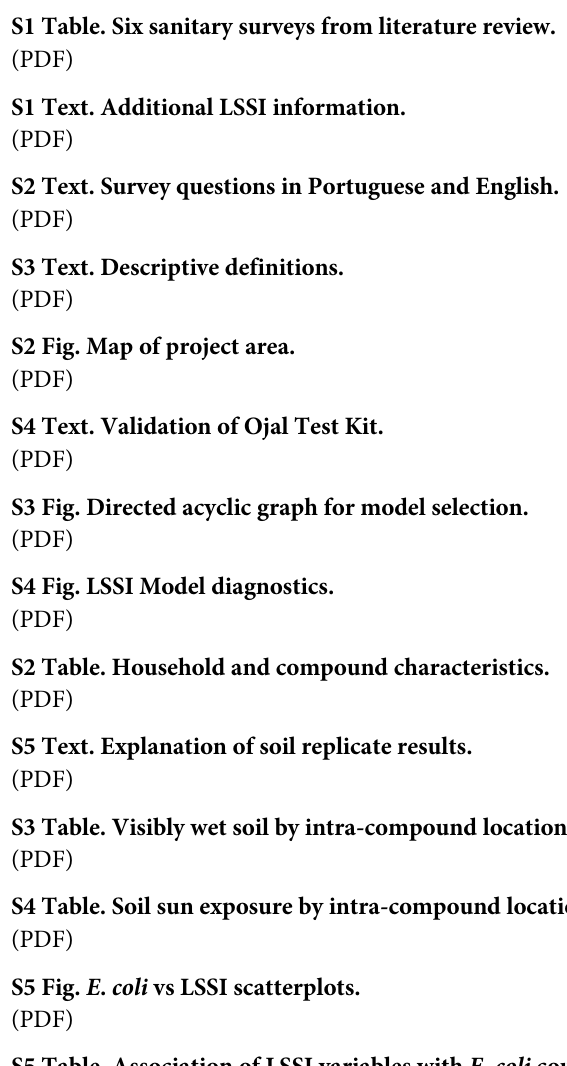
S5 Table. Association of LSSI variables with E . coli counts in